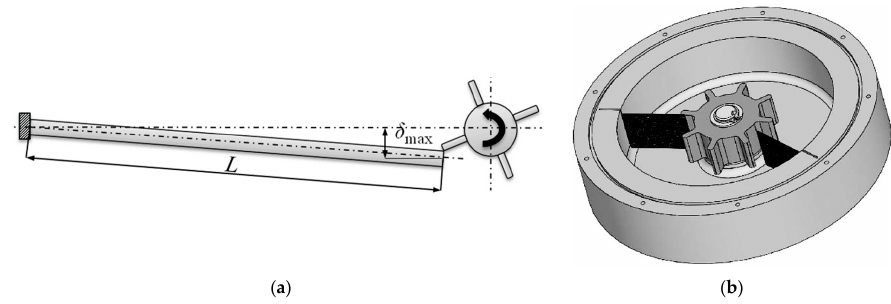
Figure 9. Scheme of the frequency up-conversion principle induced by plucking [92]-reprinted by permission from Springer Nature ( a ) and one of the thus proposed EH devices [32] ( b ).